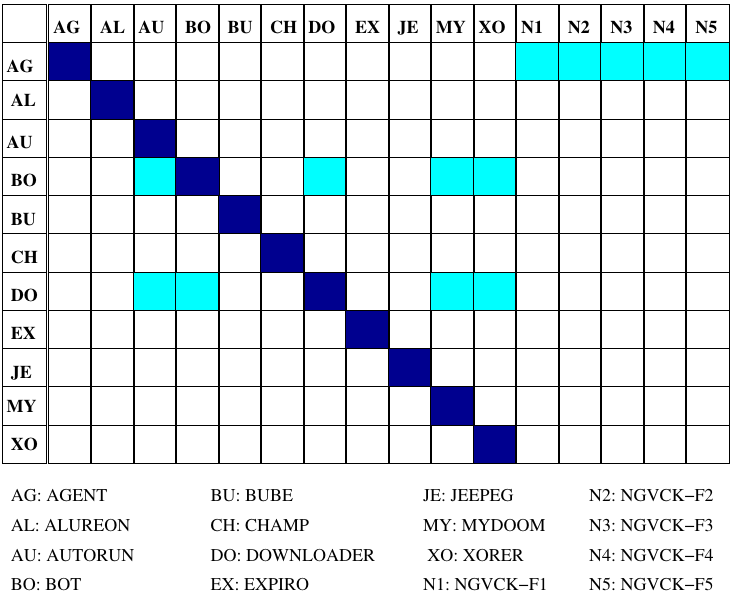
Figure 12. Overlapping families of real malware with other